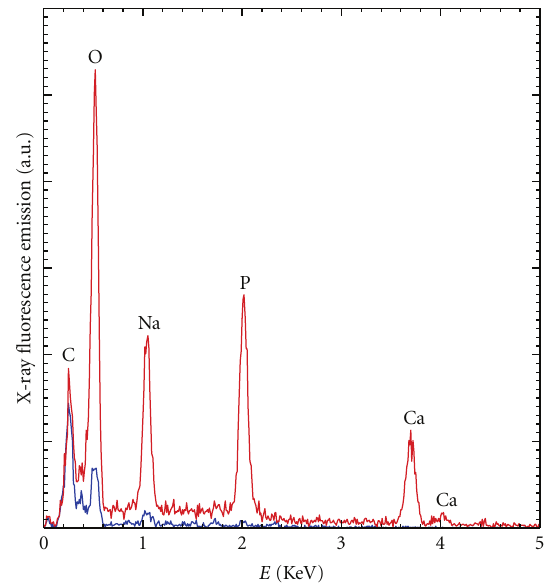
Figure 3: EDX spectra collected for the ultrastructures presented above (blue graph) and for massively calcified lesions within the same valve (red graph) (SEM not shown). The contributions of light elements such as C (carbon), O (oxygen), and Na (sodium) are predominating within crystalline ultrastructures, while massive calcifications display higher peaks of elements such as P (phosphor) and Ca (calcium). Results are fitting into the chemical composition given by FT-IR (see